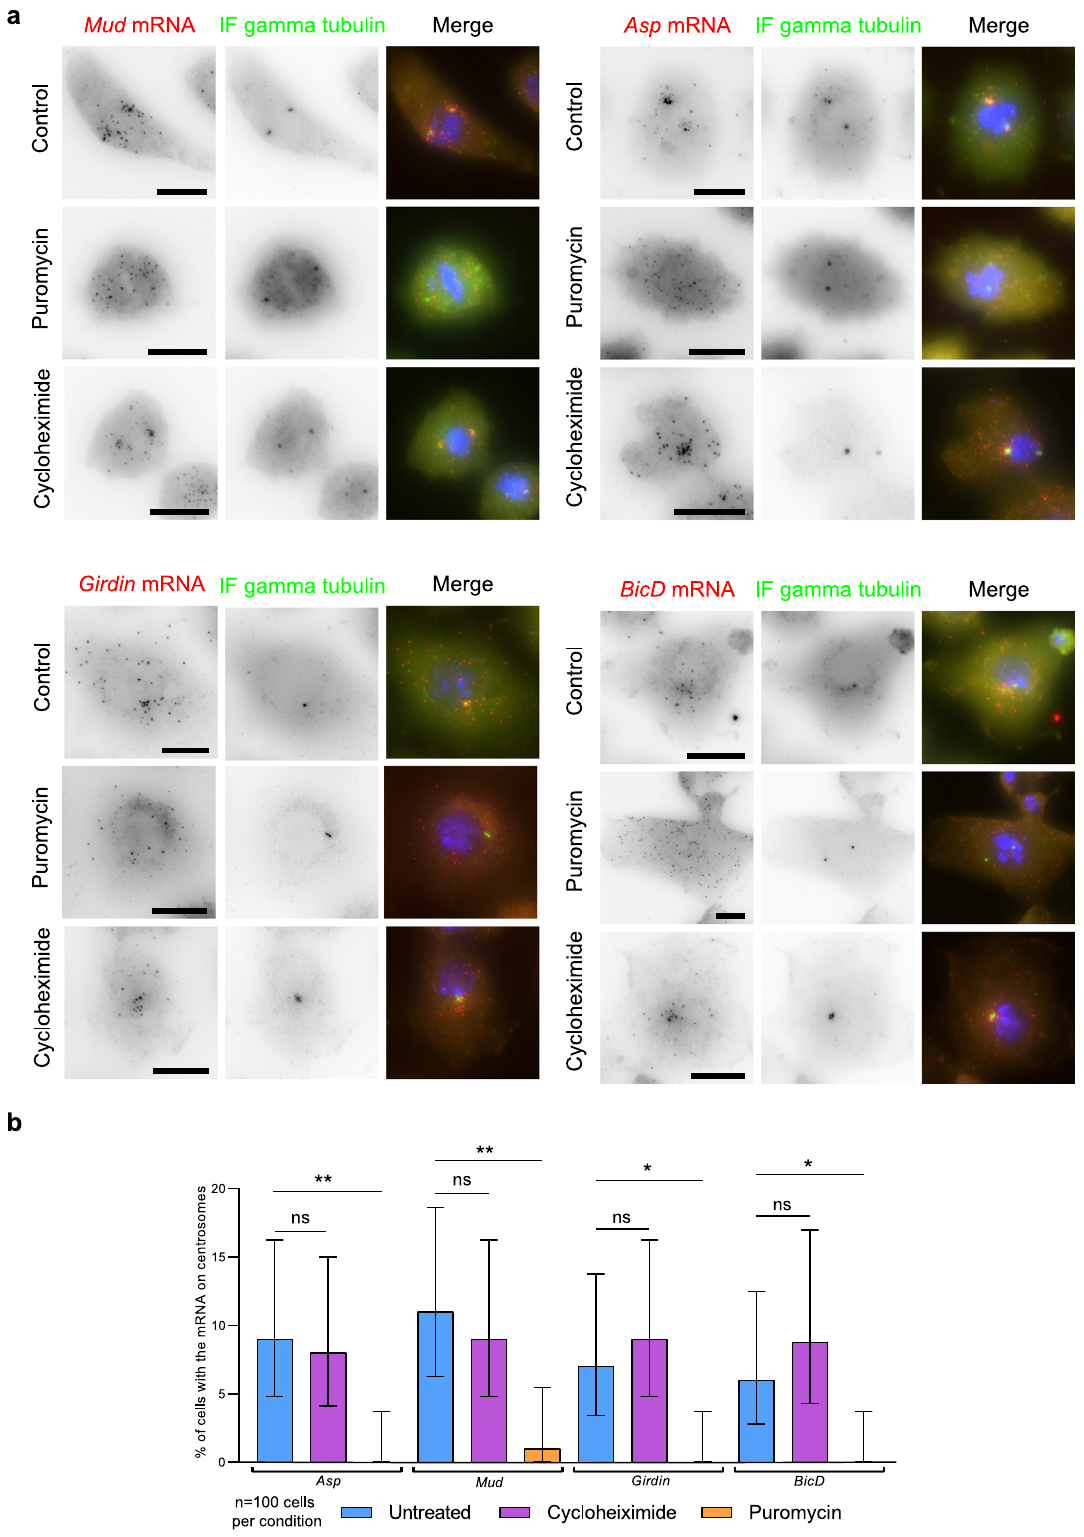
“ kinetochore ” , “ condensed chromosome ” , “ centromere ” , “ telomere ” . This repre- sented 932 human genes that were manually curated to a fi nal list of 728 genes, which were processed for high-throughput smFISH. Signals were obtained for 602 of the genes. Many genes for which no signal could be obtained are not expressed in HeLa Centrin1 – GFP cells. To perform high-throughput smFISH, a pool of DNA oligonucleotides (GenScript) was used to generate the primary probes. The oligonucleotide